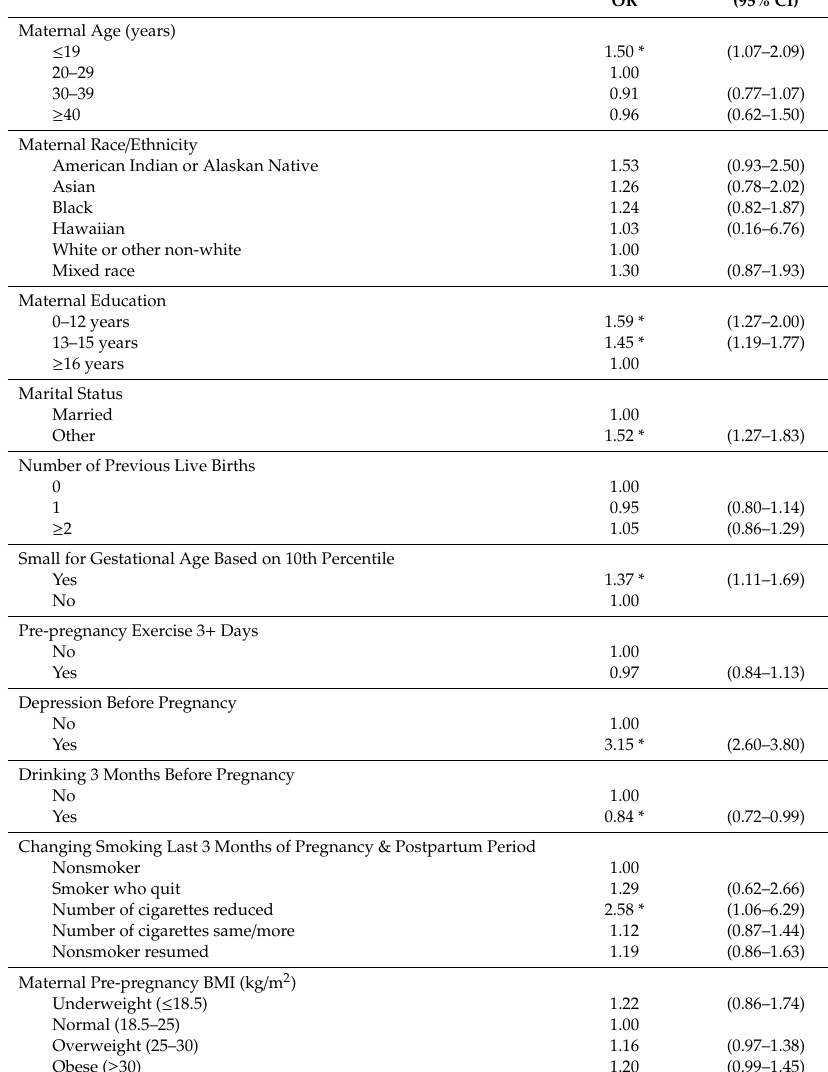
Table 2. Associations between maternal demographics and lifestyle factors and postpartum